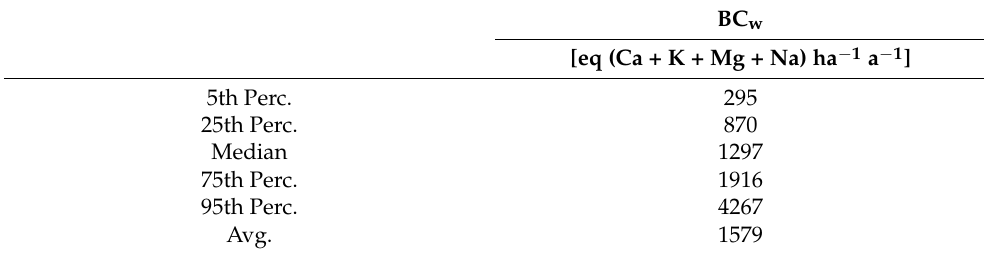
Table 21. Statistical distribution of the determined release rate of base cations through weathering